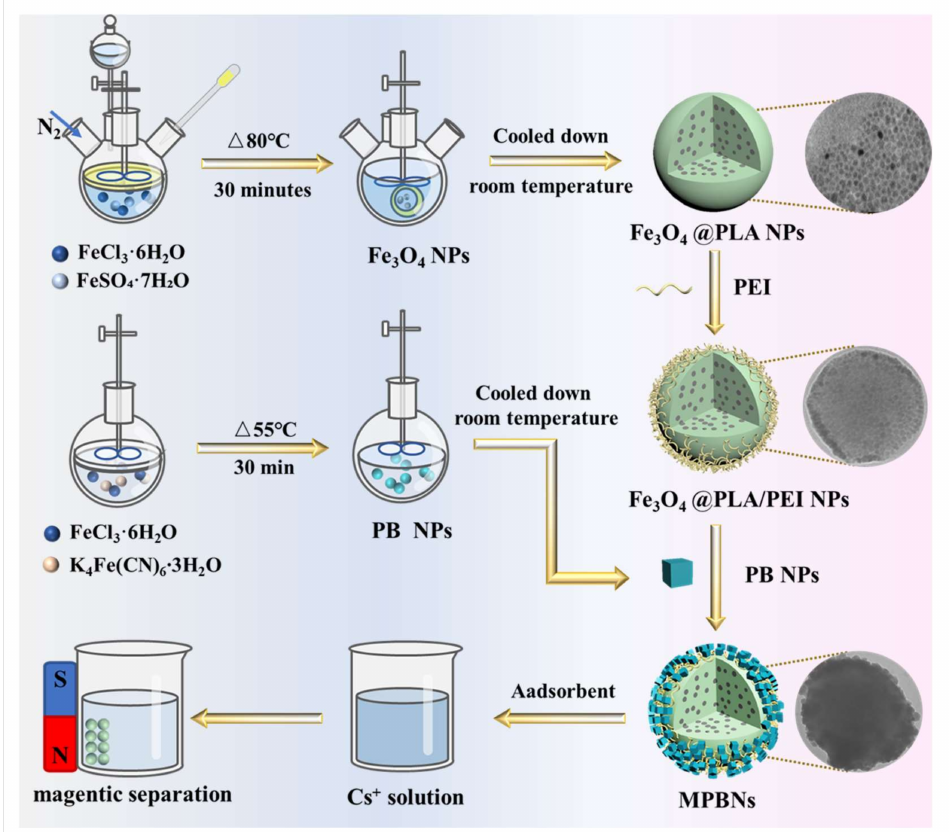
Figure 1. Schematic diagram of the preparation process of MPBSNs and their application to remove cesium